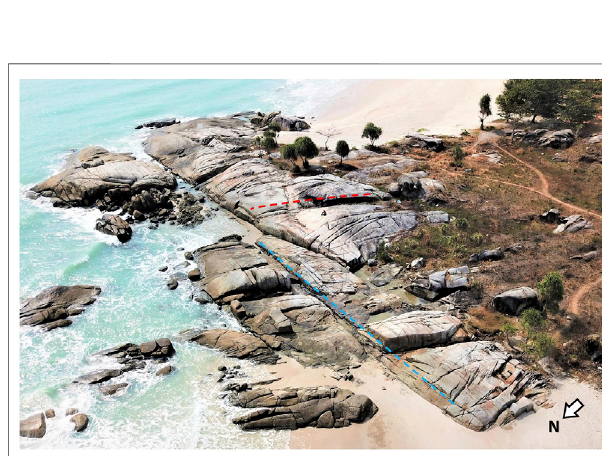
FIGURE 1 | Imagery of the outcrops: (A) SL01 and (B) SL02 along with the projection of linear scanlines location (red lines). Both outcrops are located on Bangka Island, Indonesia (106.1628 ° E longitude and 1.8688 ° S latitude and 106.1735 ° longitude and 1.8771 ° latitude for SL01 and SL02, respectively).